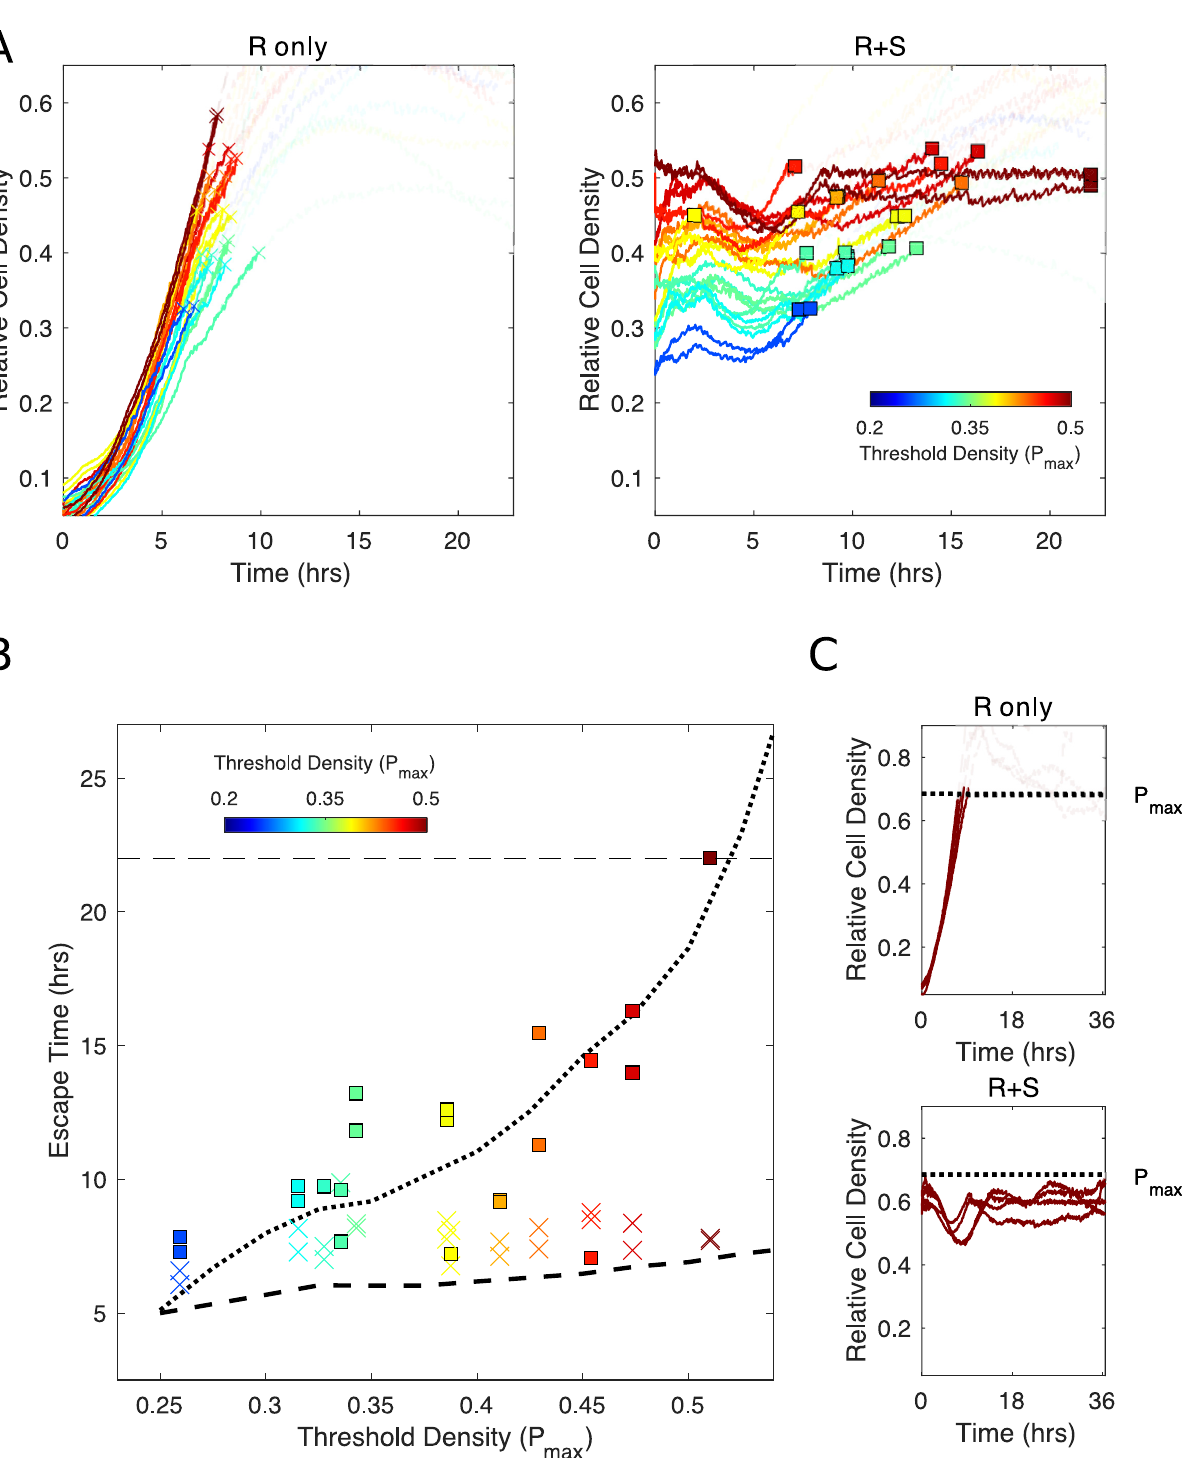
Fig 5. Escape time depends sensitively on P max for mixed, but not for R-only, population. (A) Growth curves for R-only (left) and mixed (right) populations for different values of P , ranging from 0.2 (blue) to 0.5 (red). Curves transition from opaque to transparent as they eclipse P max crossover point is marked with an “ × ” (R-only populations) or square (mixed populations). (B) Failure time (i.e., time to cross threshold) for experiments in panel A (“ × ” for R-only, squares for mixed populations; note that one yellow square falls below the axis limits). Dotted (dashed) curves are predictions from theoretical model for mixed (R-only) populations. (C) Example long-term (35+hours) experiment in the regime in which P larger than the steady-state population density. As in panel A, growth curves become transparent after crossing threshold. In all curves, density is